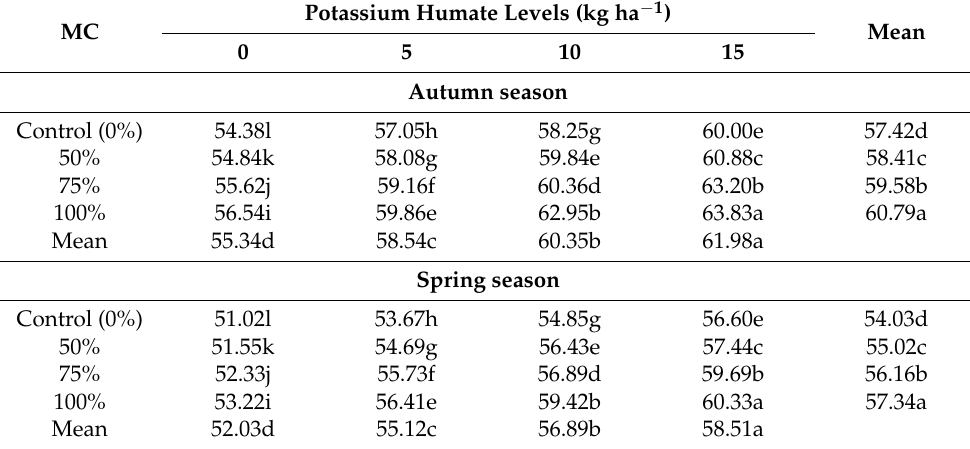
Table 3. Total biomass (tons) per hectare of tomatoes, affected by various K-humate and MC levels, under field conditions during autumn.